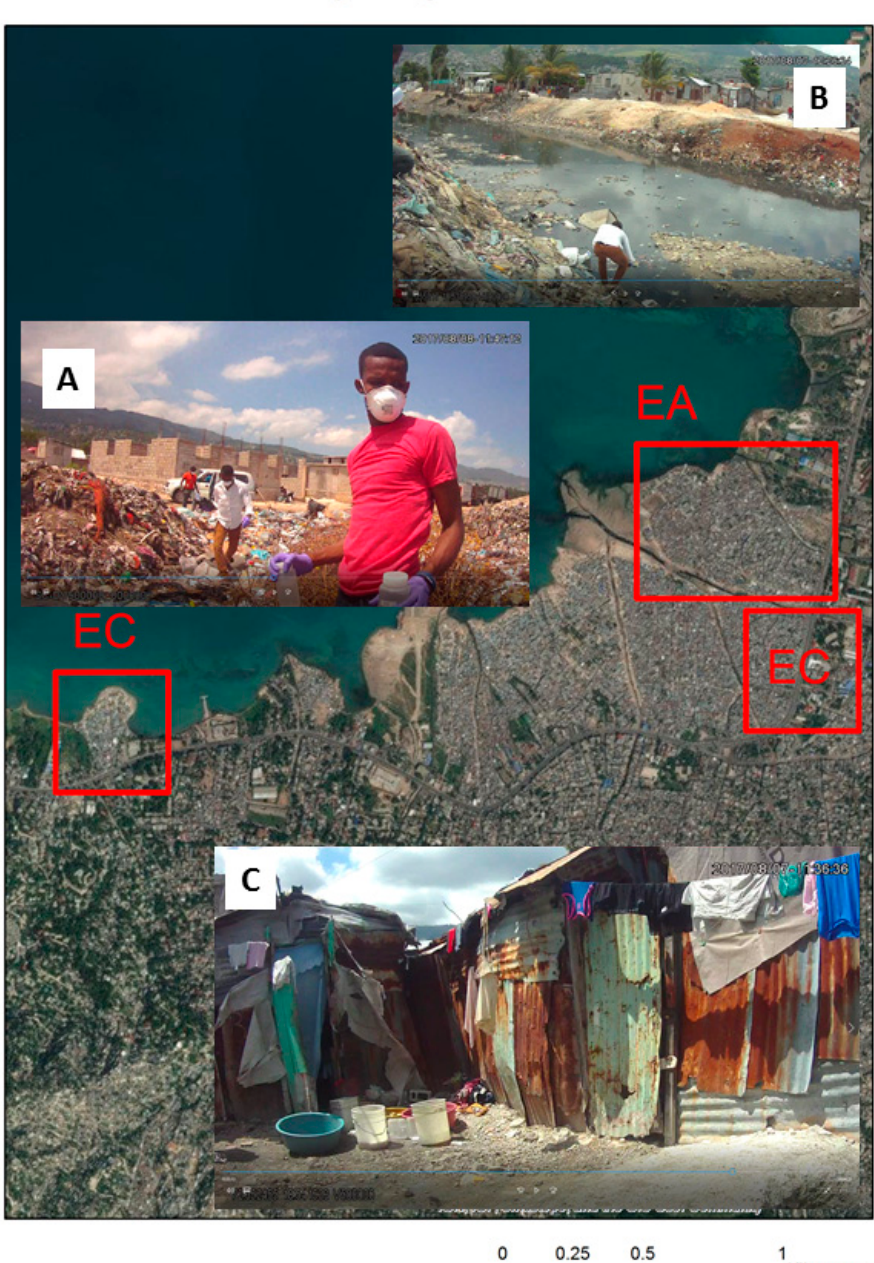
neighborhood EB; ( C ) study neighborhood Figure 1. Examples from the three study neighborhoods.